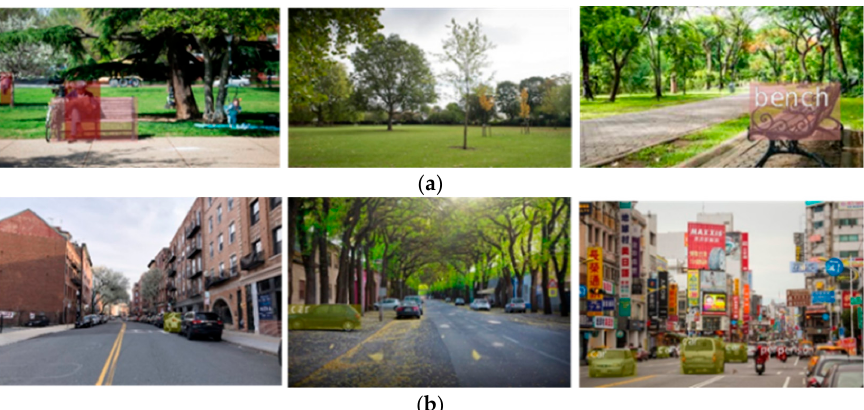
Figure 10. Object recognition results: ( a ) first set (target object: person); ( b ) second set (target object: traffic light).